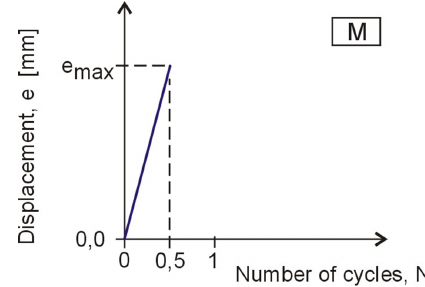
Figure 2: Monotonic loading